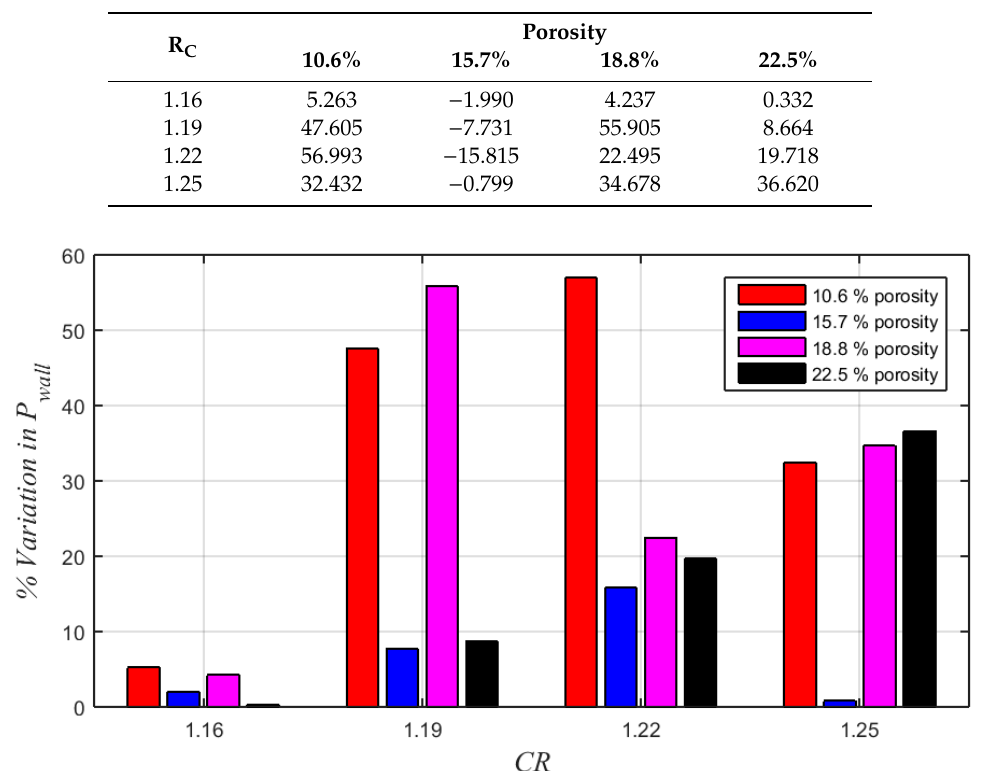
Figure 16. Variations of wall static pressure for the controlled intakes at various contraction ratios (X = 0.48 L). Table 4. Variation of wall static pressure percentage due to wall ventilation at the downstream proximity (X/L = 0.7).